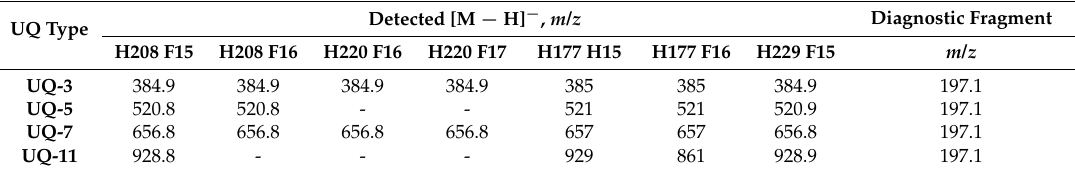
Table 2. Main mass ions [M − H] − of ubiquinones observed in protein-polyphenol complexes.